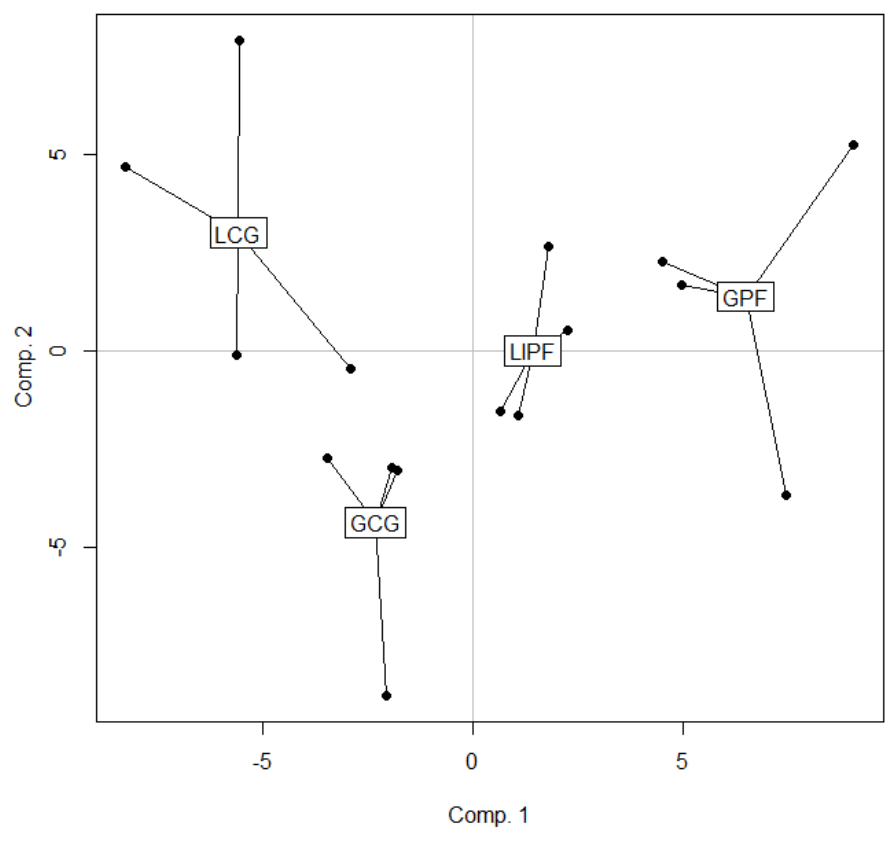
Figure 4: Graphical representation of the four population samples on the two first axes of the PLS-DA analysis. The first and second axes explained respectively 11.94 and 7.99% of the total variance among samples (p=0.008). The acronyms of the sampling locations are as follows: Grimsey - G; Langanes - L; Lundey Island - Li. PF refers to Atlantic puffin ( Fratercula arctica ) and CG to Common guillemot ( Uria aalge